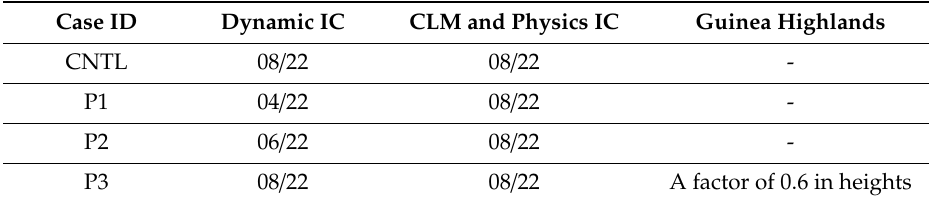
Table 1. Sensitivity experiments for studying the dependence of AEW simulations on di ff erent dynamic ICs and modified Guinea highlands. Initial conditions for physics and land processes remain the same in all experiments, as shown in the third